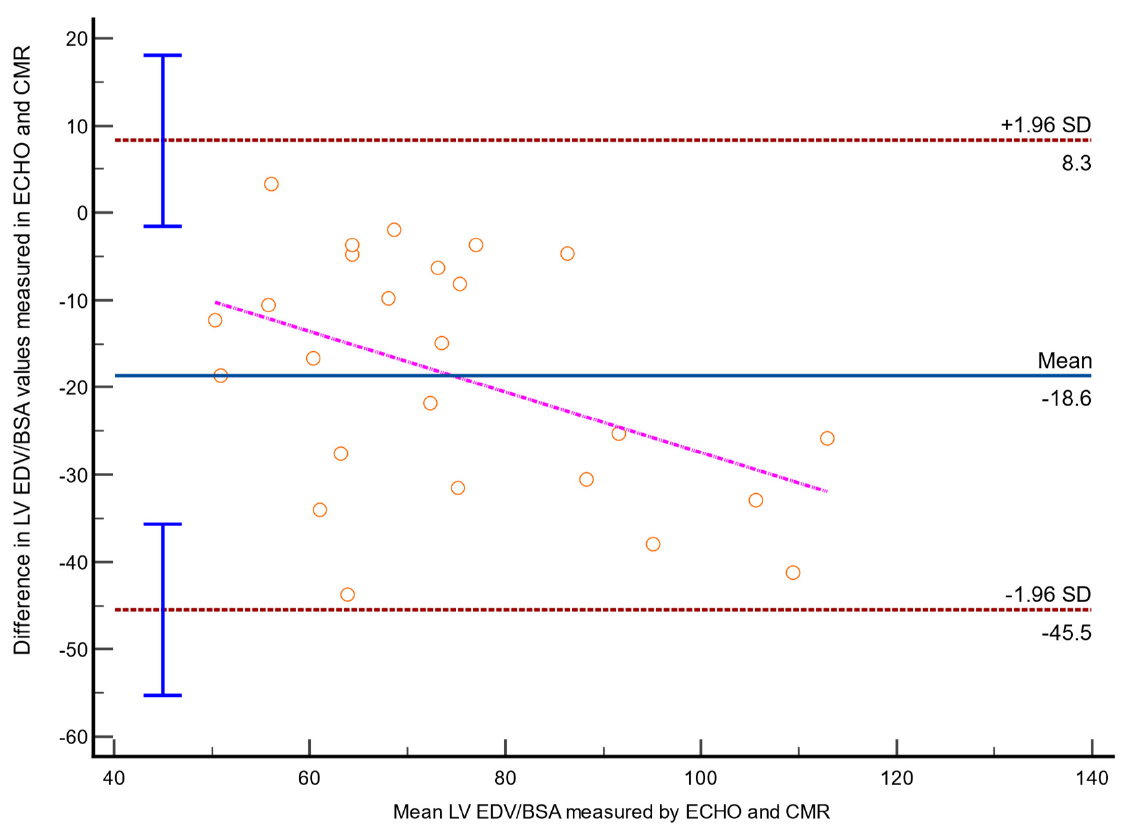
Figure 3. Bland–Altman plot of left ventricular end-diastolic volume mass indexed to body surface area (LV EDV/BSA). ECHO indicates echocardiography; CMR, cardiovascular resonance imaging; SD, standard deviation.